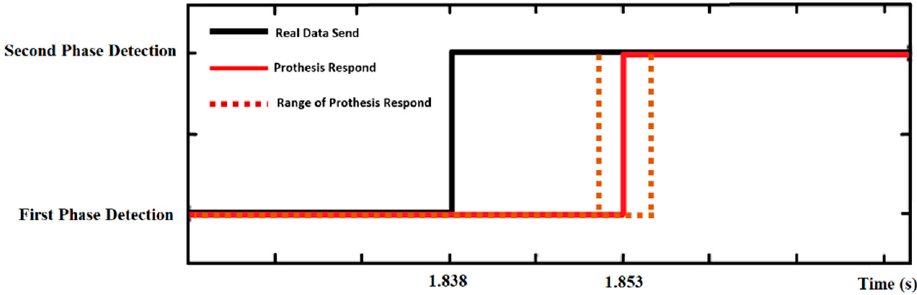
Figure 9. Delay in data transmission via Bluetooth connection for transtibial prosthesis control. With the actual data transmission time and the length of time the prosthesis takes to respond, there is an approximately average delay of 15 ± 2 ms, which is an acceptable delay for receiving data and would not affect the control of the